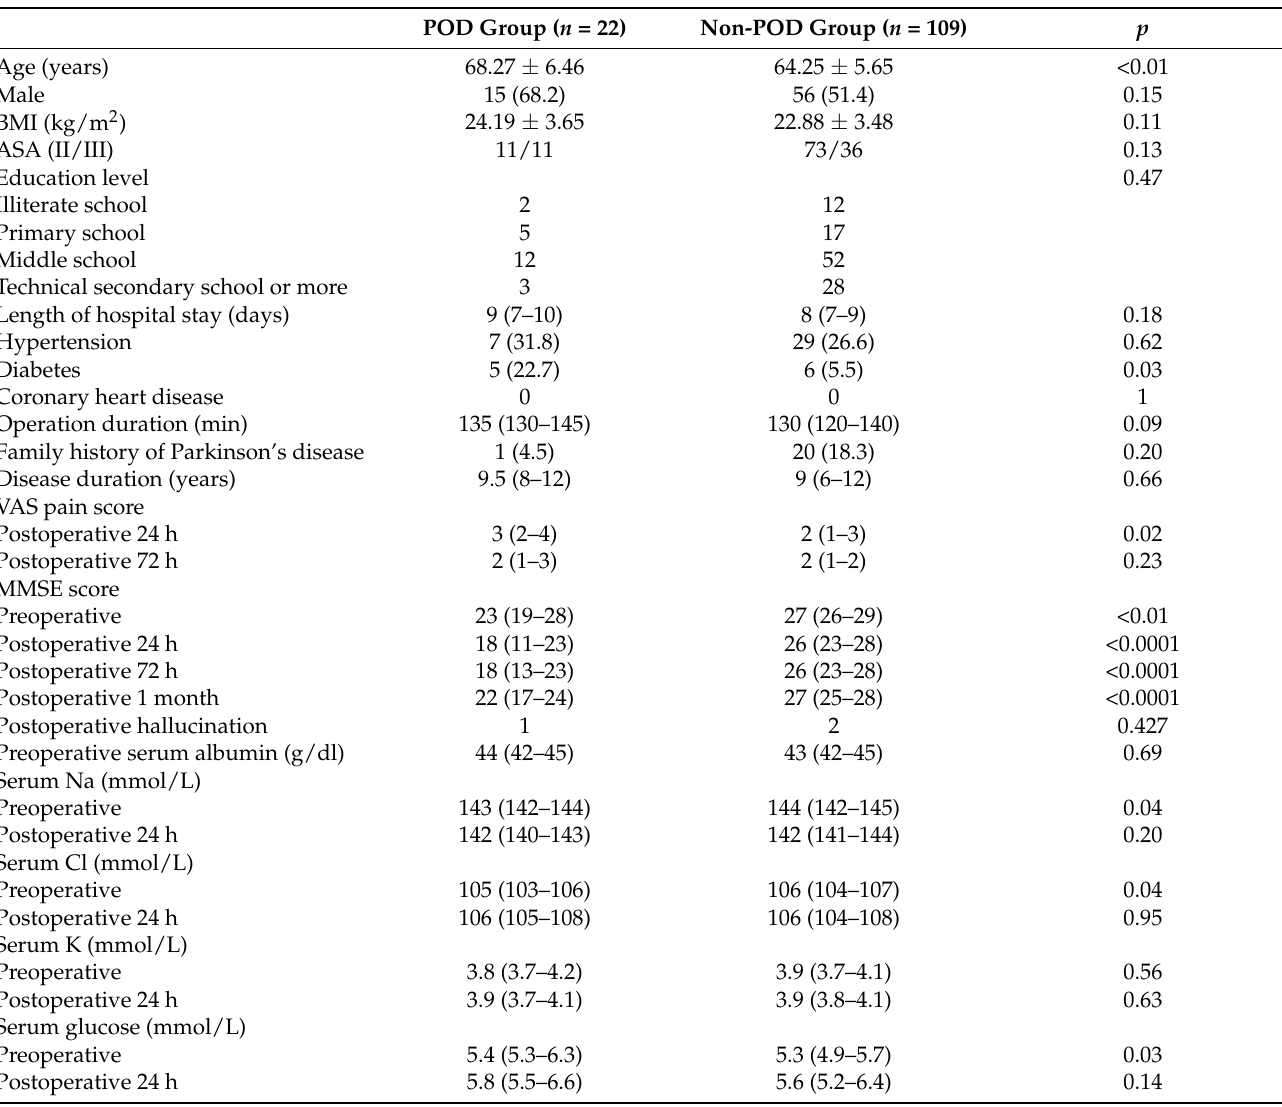
Table 1. Baseline characteristics of the study population.